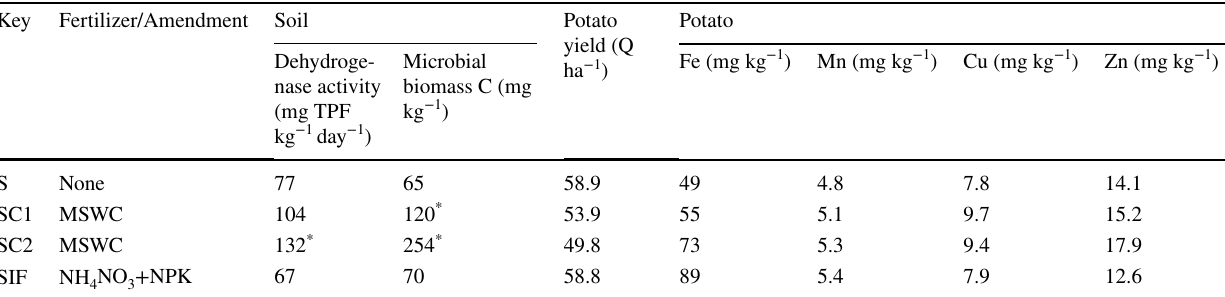
Table 5 Soil biological activity, potato yield and metal plant uptake: potato tuber composition